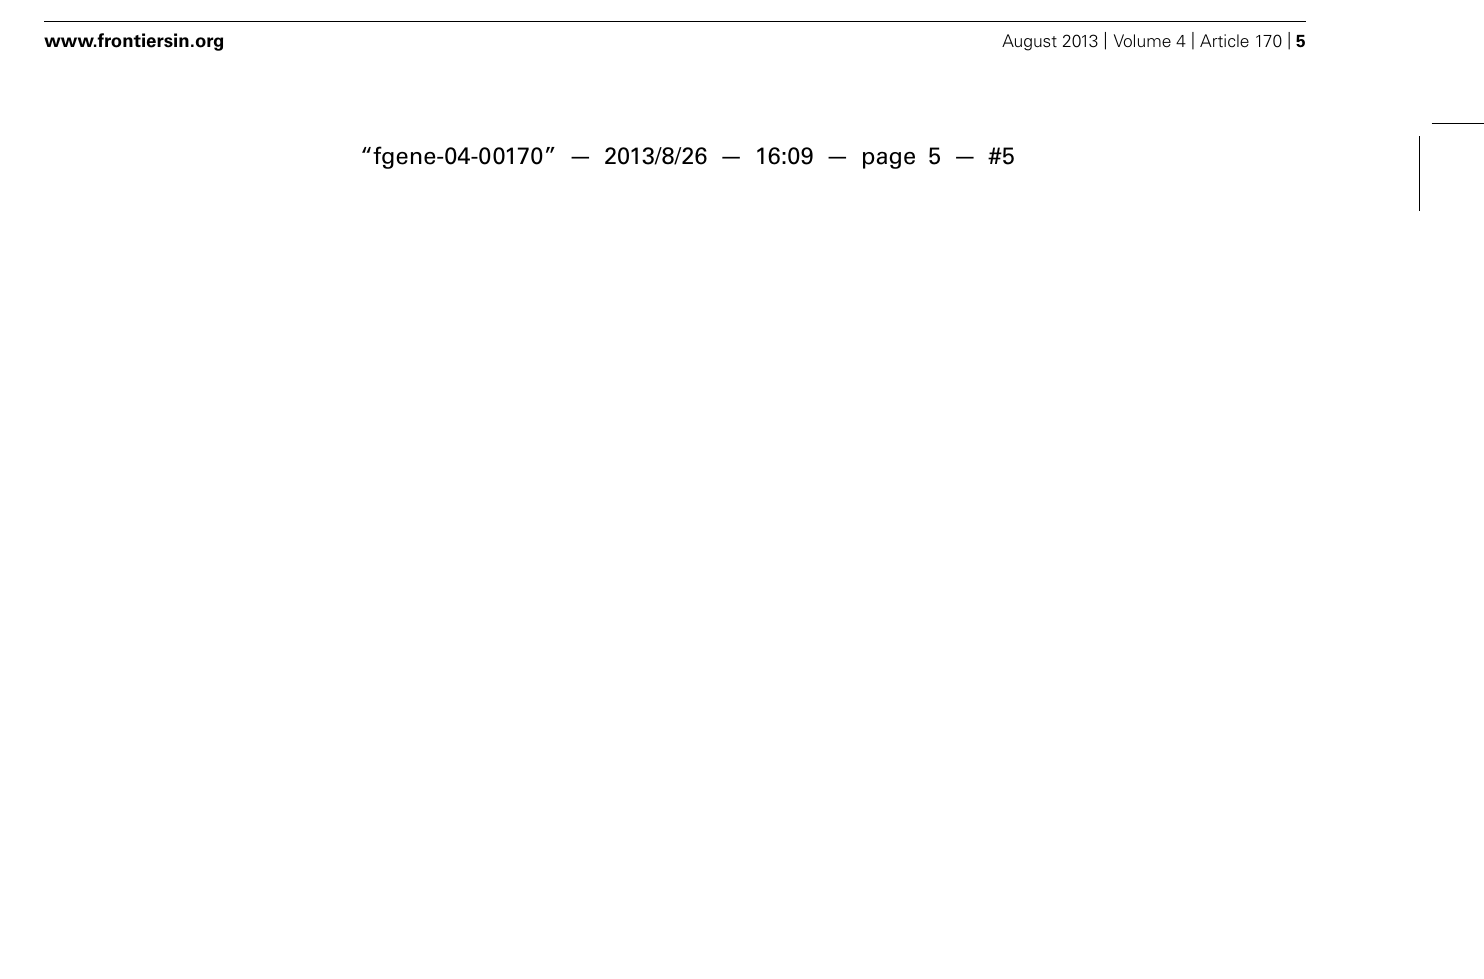
scrambled control ( n = 5). (B) NODAL and STOX1 mRNA expression in SGHPL-5 cells after addition of conditioned media from differentiatedT-HESC cells treated with siRNAs against Nodal relative to scrambled control ( n = 3). * P < 0.05.